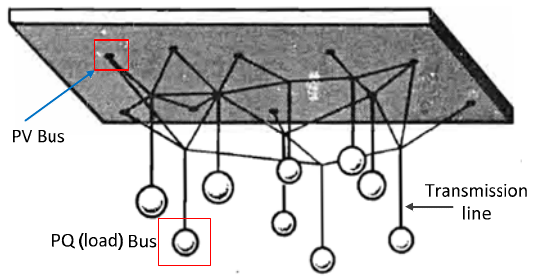
Figure 10. The simple mechanical system analogous to the power network.